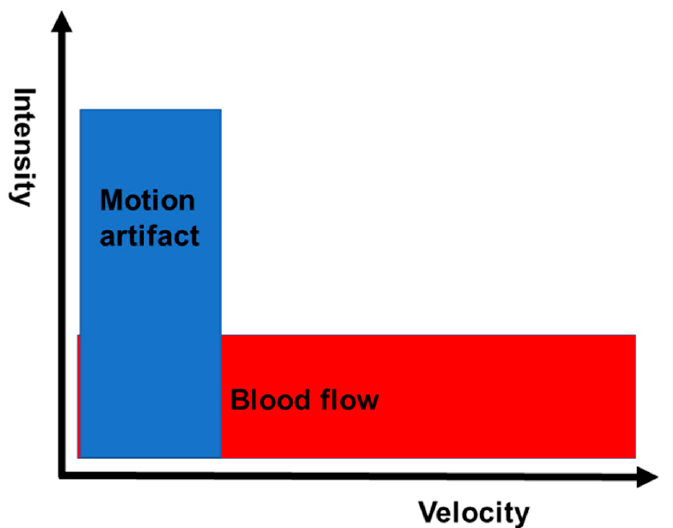
Figure 1. Doppler signals. The signals from motion artifacts overlap the low-speed flow components. Overlap due to motion artifact, which are unnecessary signals, hinders the visualization of low-flow signals.